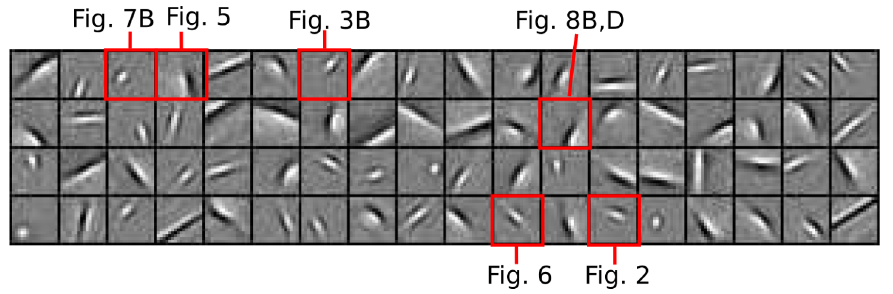
Figure 1. Subpopulation of dictionary elements (‘‘CRFs’’) studied. The 72 dictionary elements that were recorded from in the model simulation. Dictionary elements were optimized for sparse coding under natural scenes (as described in the text) and selected for well-localized CRFs in the image patch. The units whose single cell activities are presented in later figures are indicated by red rectangles.